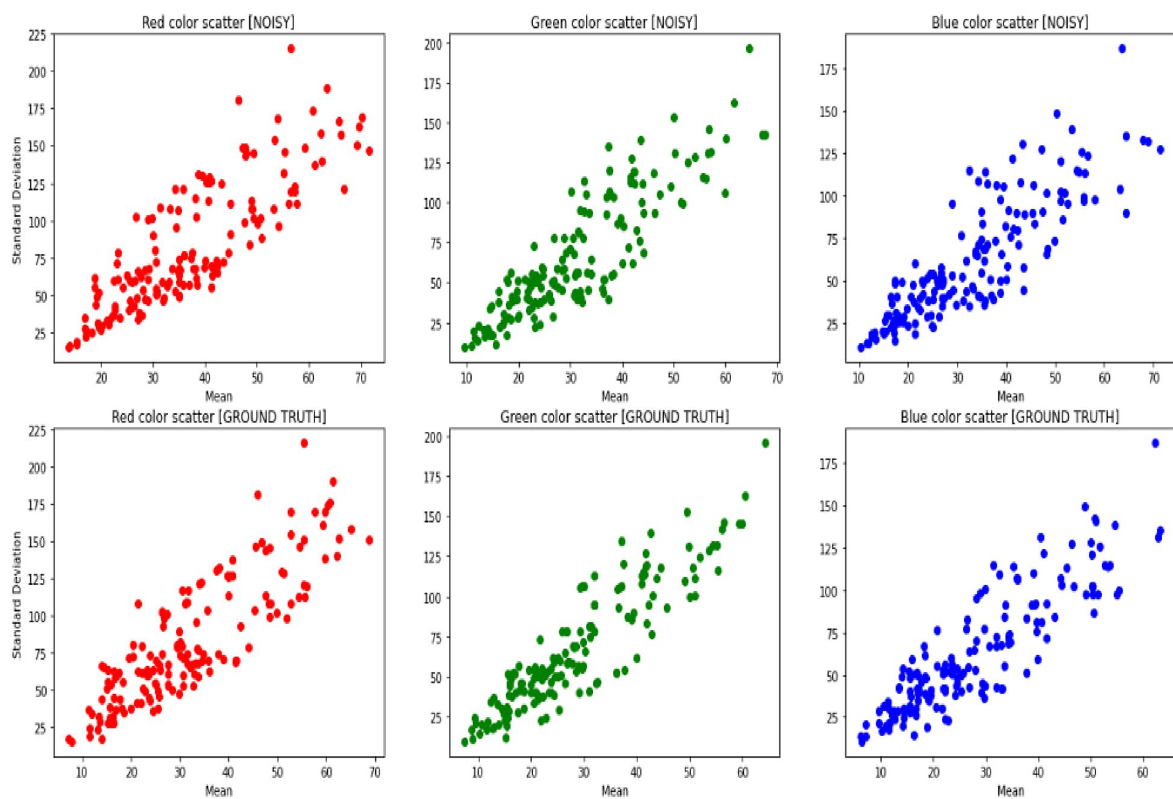
Fig. 12 Mean, Standard Deviation of Input test